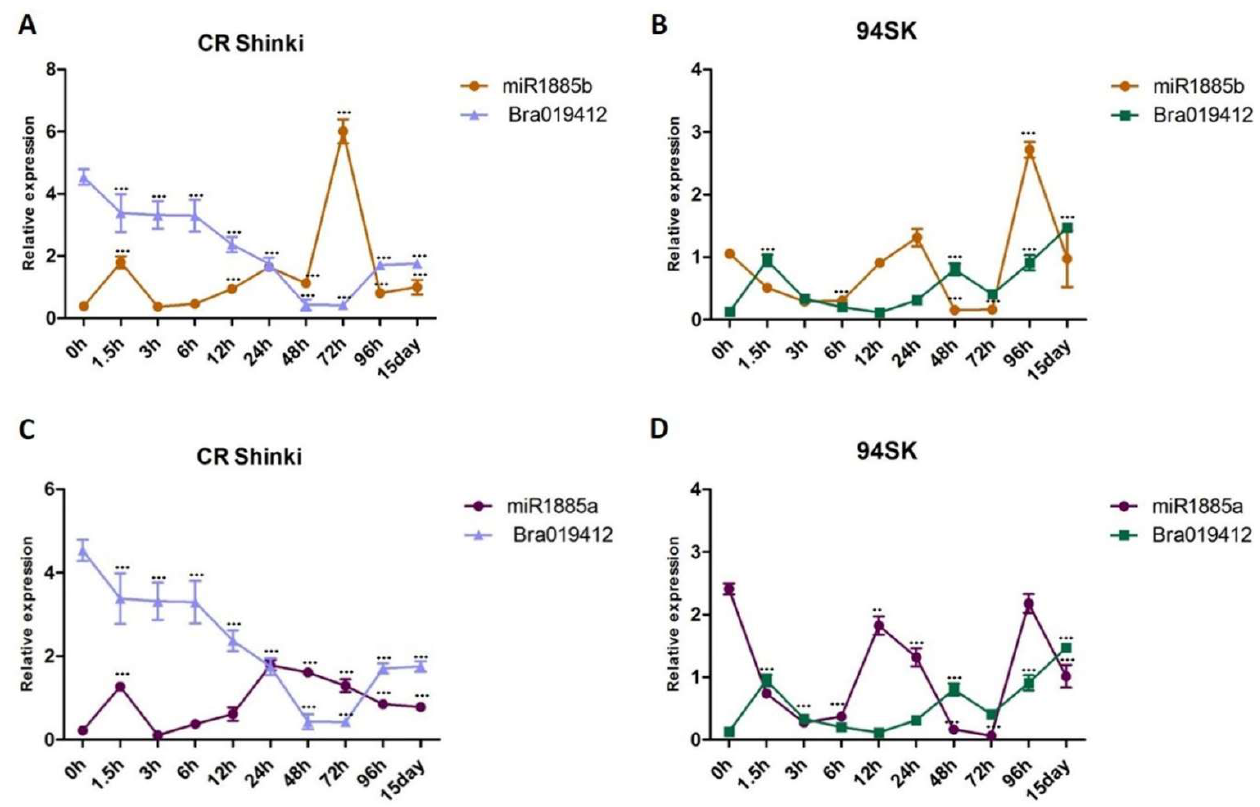
Figure 4. Analysis of the expression of Bra019412 with miR1885b or miR1885a in the root tissues of B. rapa infected with P. brassicae . Correlation of the expression between ( A ) miR1885b and Bra019412 in CR Shinki, ( B ) miR1885b and Bra019412 in 94SK, ( C ) miR1885a and Bra019412 in CR Shinki, and ( D ) miR1885a and Bra019412 in 94SK as determined by qRT-PCR. The transcript level of the B. rapa actin gene served as the internal control for target gene expression, whereas the U6 snRNA level served as the internal control for mature miRNA expression. The miRNA and gene expression levels over time in inoculated plant samples were normalized against the corresponding expression levels in untreated plants. For each time-point, more than six individual plants were pooled ( n > 6) and independent experiments were replicated three times. Standard error bars are presented for each time-point. Asterisks indicate a significant difference at * p < 0.01, ** p < 0.05, and *** p < 0.001.